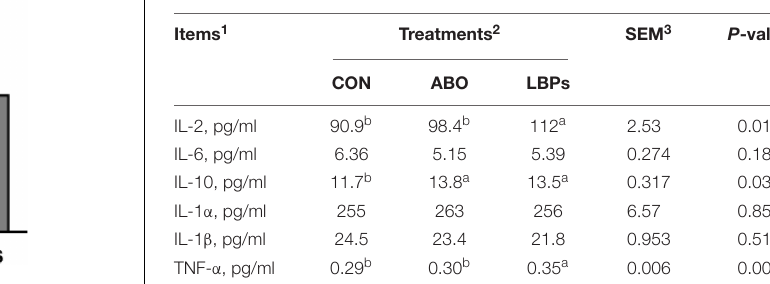
TABLE 4 | Effects of dietary LBPs supplementation on immunologic factors levels in serum of weaned